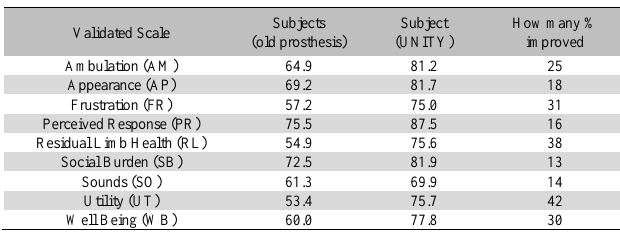
Table 1: Prosthesis Evaluation Questionnaire